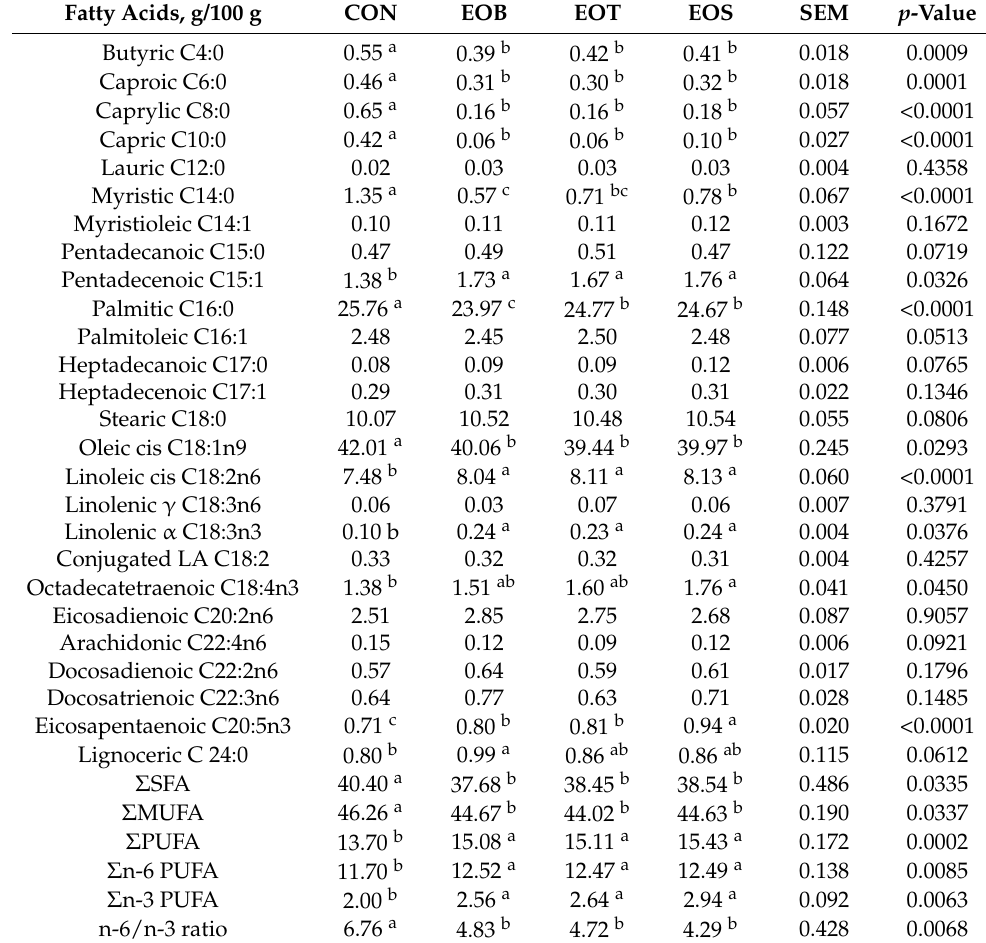
Table 4. Effect of dietary supplements on the fatty acid composition of thigh meat